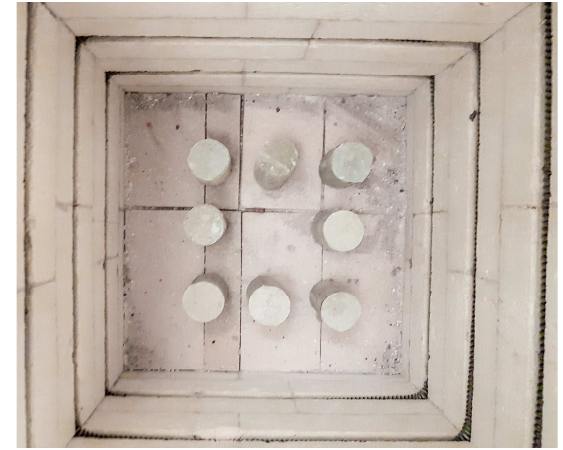
Figure 1. Internal view of the electric